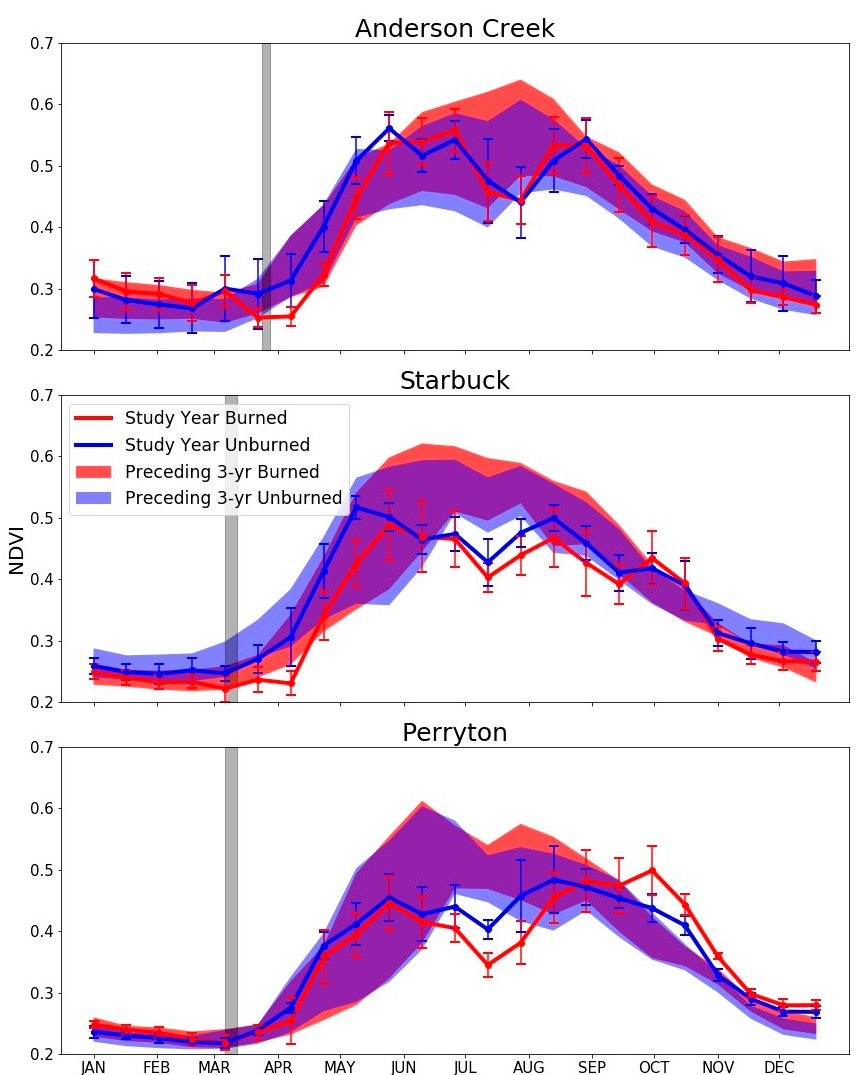
Figure 2. Three year average Normalized Difference Vegetative Index (NDVI) values for the unburned plots (blue shaded) and burned plots (red shaded) of the Anderson Creek (top), Starbuck (middle), and Perryton (bottom) wildfires. Purple shaded area is overlap of burned and unburned plots in this and subsequent figures. Fire year NDVI averages for the unburned (blue) and burned (red) plots are shown as solid lines with error bars of one standard deviation. Time of fire is marked by grey shaded columns.